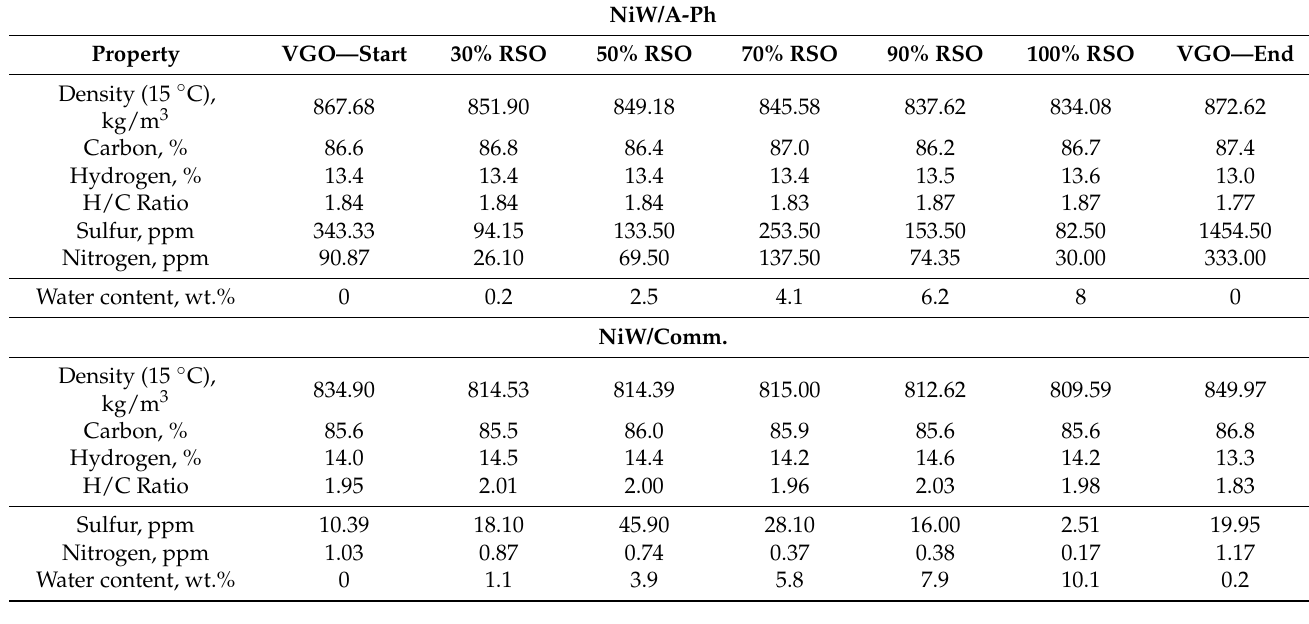
Table 2. Characteristics of the liquid products: elemental composition, H/C ratio, density, and water content of the products collected by processing each feedstock blend.